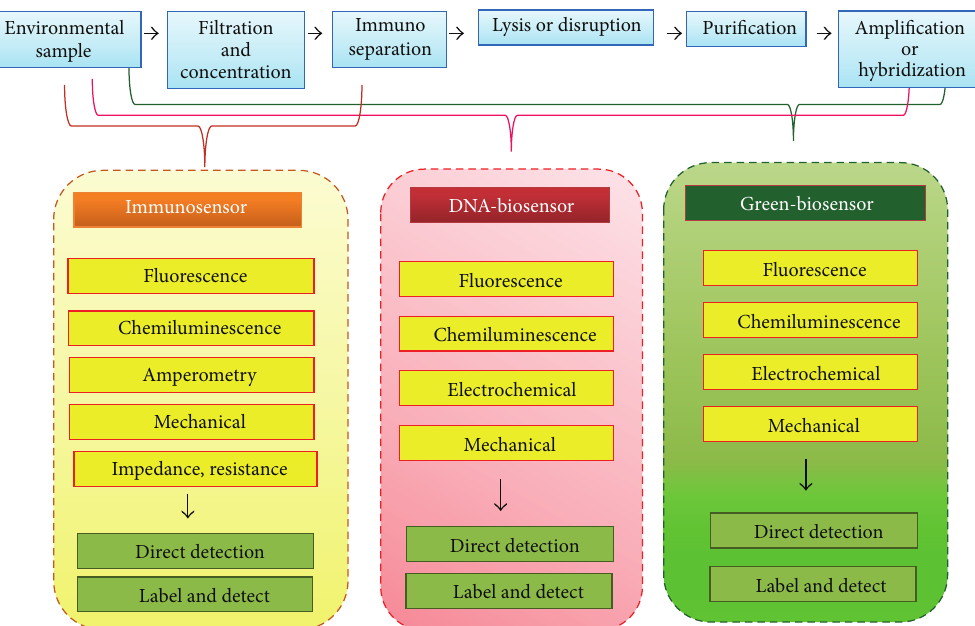
Figure 4: Common procedures for detection of certain water-borne pathogens in environmental matrices and progressive development of respective bionanosensors including immunosensor, DNA-based sensor, and others. Irrespectively, preprocessing steps of necessity initially require filtration and concentration, and then an immunoseparation step (e.g., immunomagnetic separation) in several types of